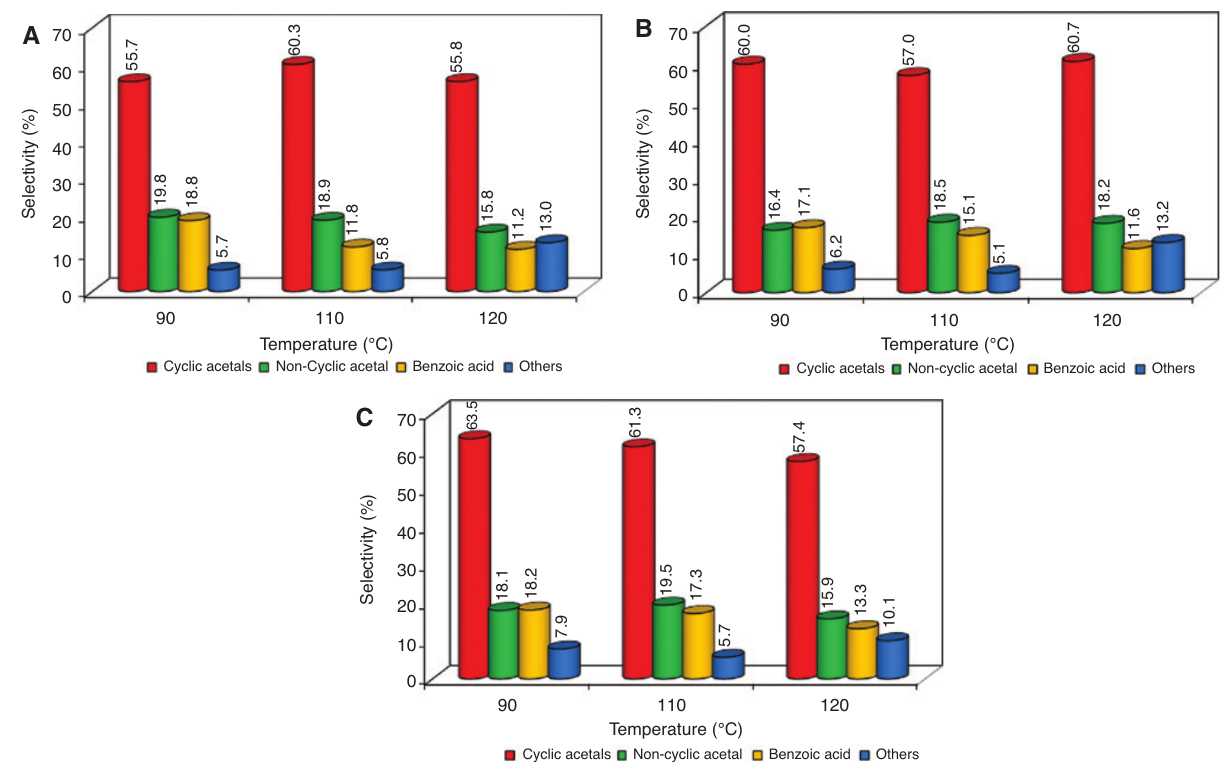
Figure 3: Selectivity (%) comparison ratios versus temperature ( ° C) about the main products of the glycerol etherification with benzaldehyde. (A) Gly/Bz ratio (1:1), (B) Gly/Bz ratio (1:2), and (C) Gly/Bz ratio (2:1). Errors deviation in 0.5–1.0%.